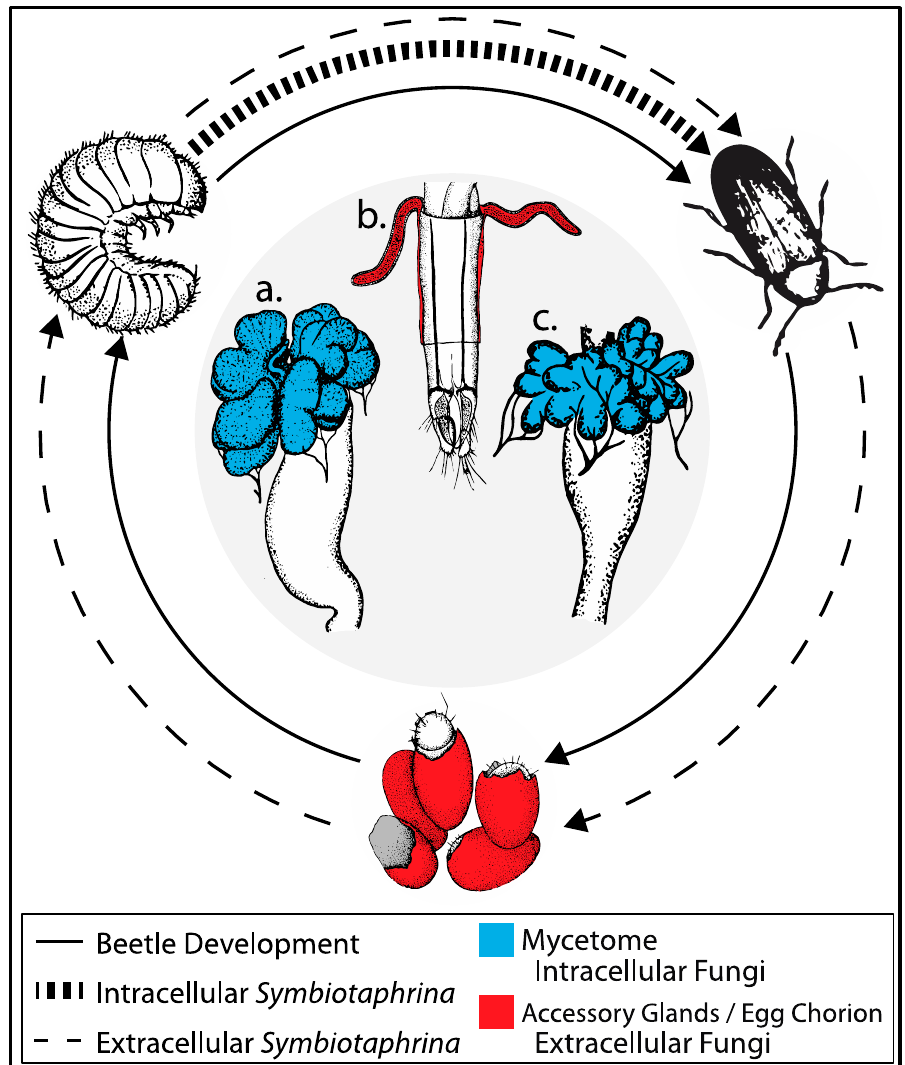
Figure 2. The life cycle of the beetle–fungus symbiosis between St. paniceum or L. serricorne and Symbiotaphrina . The fungal symbiont has extracellular and intracellular stages during the life cycle of their beetle hosts. Location and morphology of the larval midgut mycetome ( a ), adult female accessory gland ( b ), and adult midgut mycetome ( c ). The Stegobium paniceum mycetome with intracellular Symbiotaphrina in larva ( a ) and adult ( c ) is composed of deep evaginations (blue) located at the anterior midgut; posterior midgut (white). Accessory glands (red) attached to the oviposition device (white) hold extracellular Symbiotaphrina in the adult female beetle. Figure adapted from several